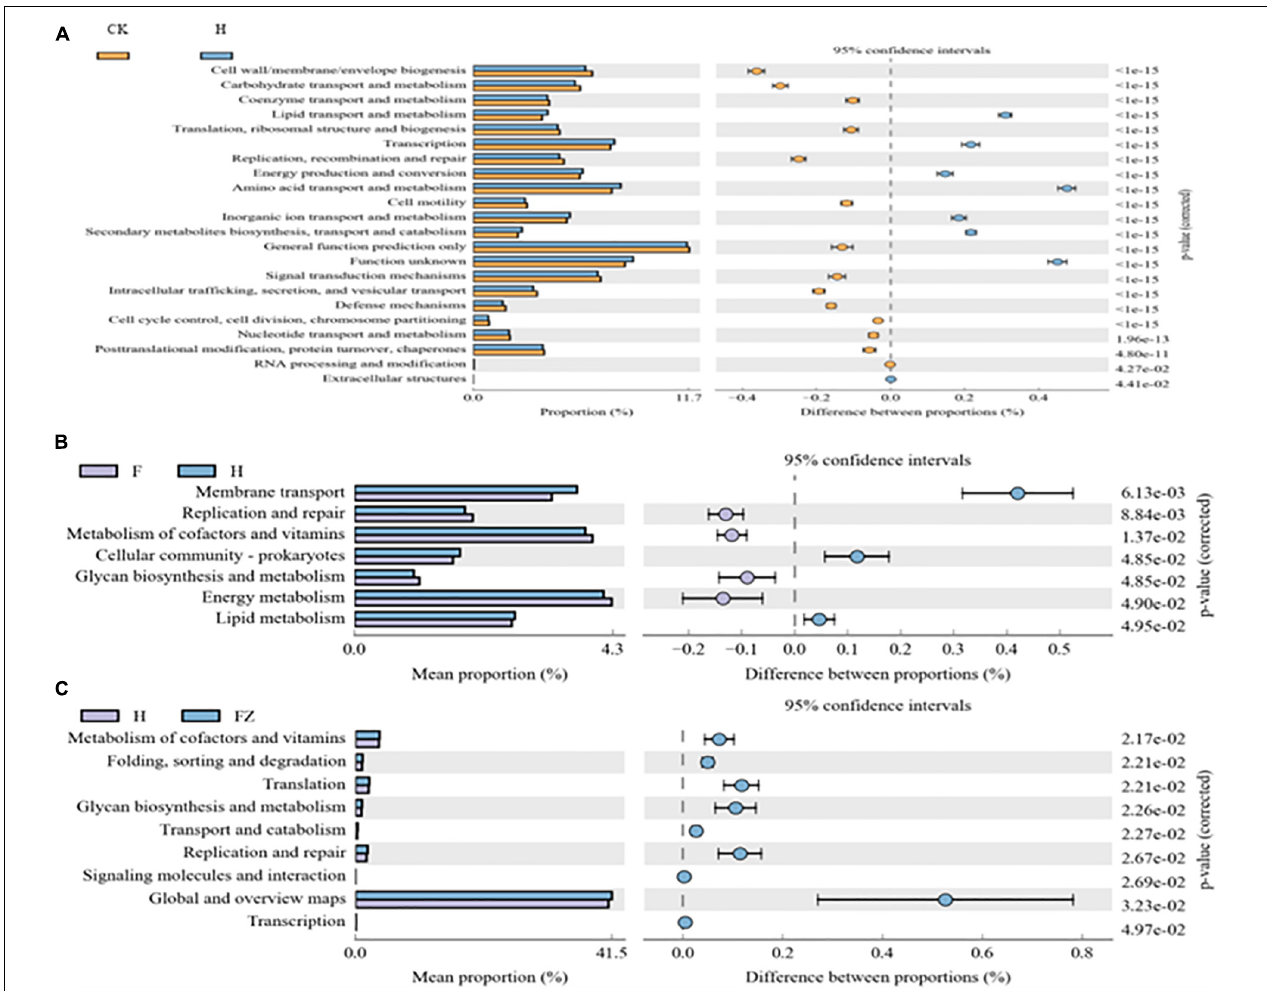
FIGURE 8 | Metagenome comparisons, as predicted by PICRUSt, showing significant differences in the functionality of microbial genes detected in soil samples collected from selected treatments: CK, control; F, F. oxysporum alone, H, HSB1 alone, and FZ, F. oxysporum + FZB42. (A) : significant comparisons between CK and H treatments, (B) : significant comparisons between F and H treatments, and (C) : significant comparisons between H FZ